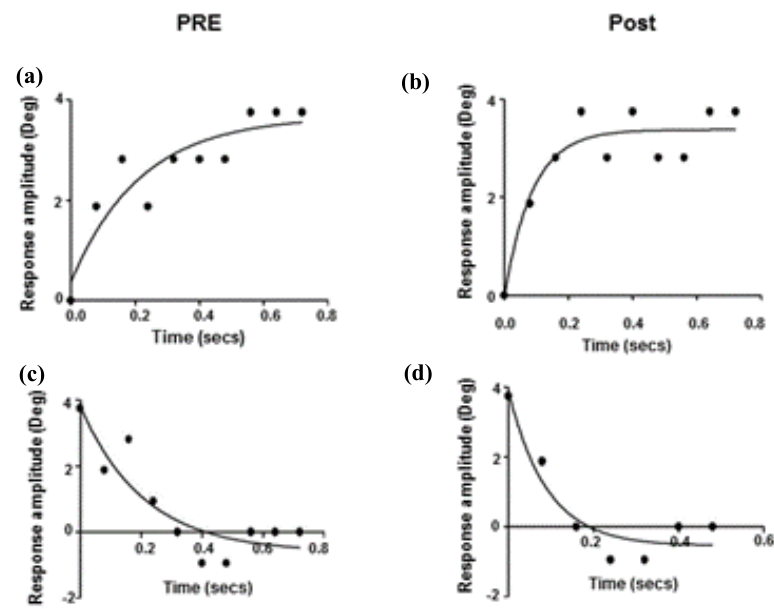
Figure 3. Horizontal vergence eye position as a function of time. Exponential fit of step vergence dynamic trajectory from right eye before ( a , c ) and after ( b , d ) oculomotor training for convergence ( a , b ) and divergence ( c , d ) in a typical mTBI subject [14].